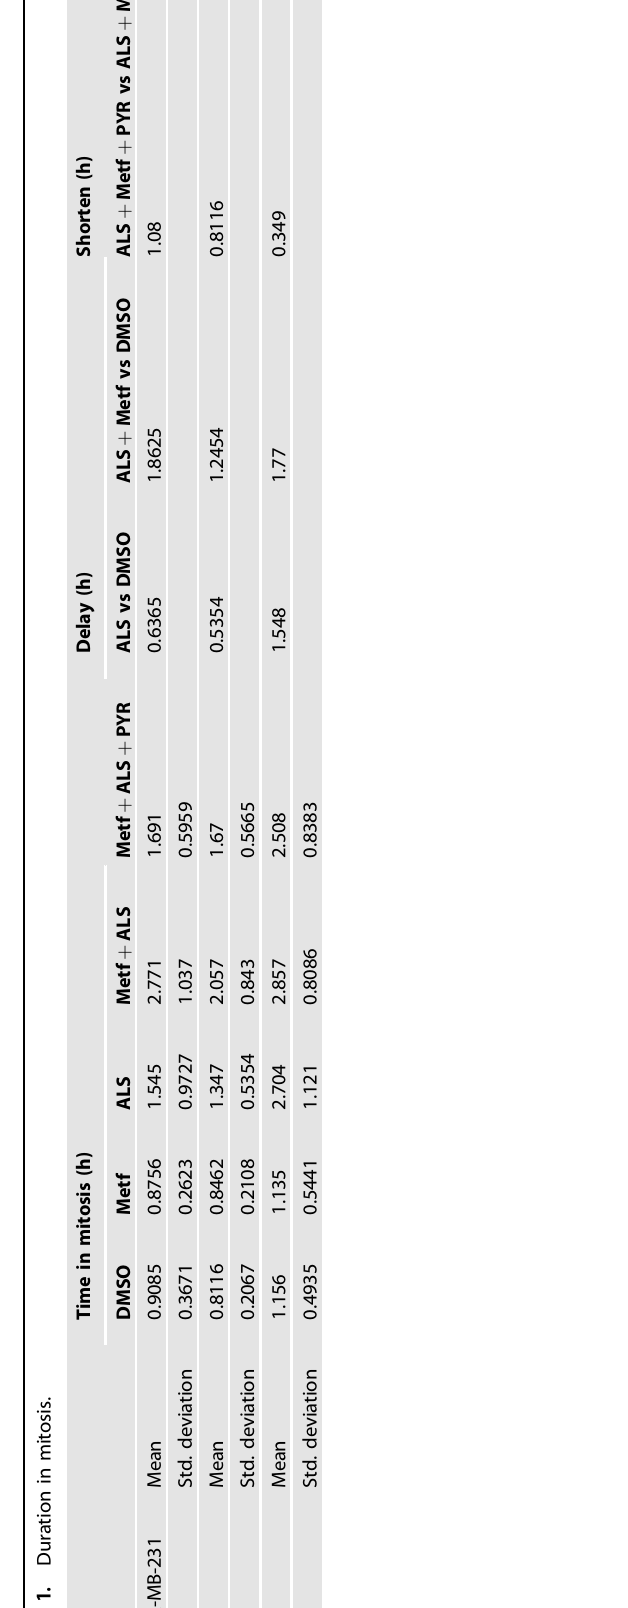
taken using a Nikon ECLIPSE Ti2 with a 10× object.